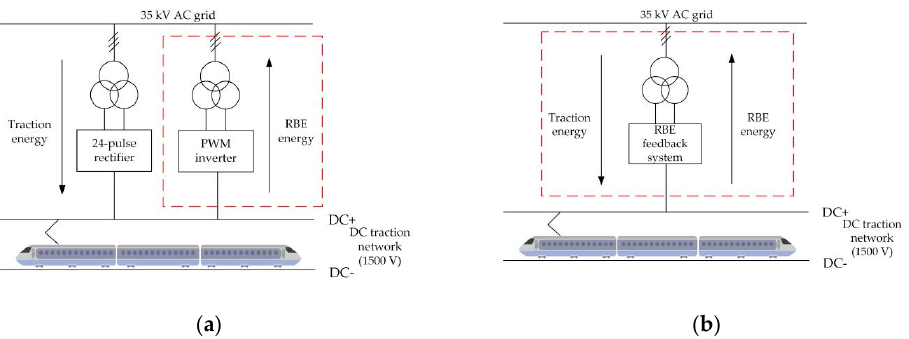
Figure 1. The RBE feedback systems: ( a ) the structure of the conventional RBE feedback system; and ( b ) the structure of the proposed RBE feedback system.